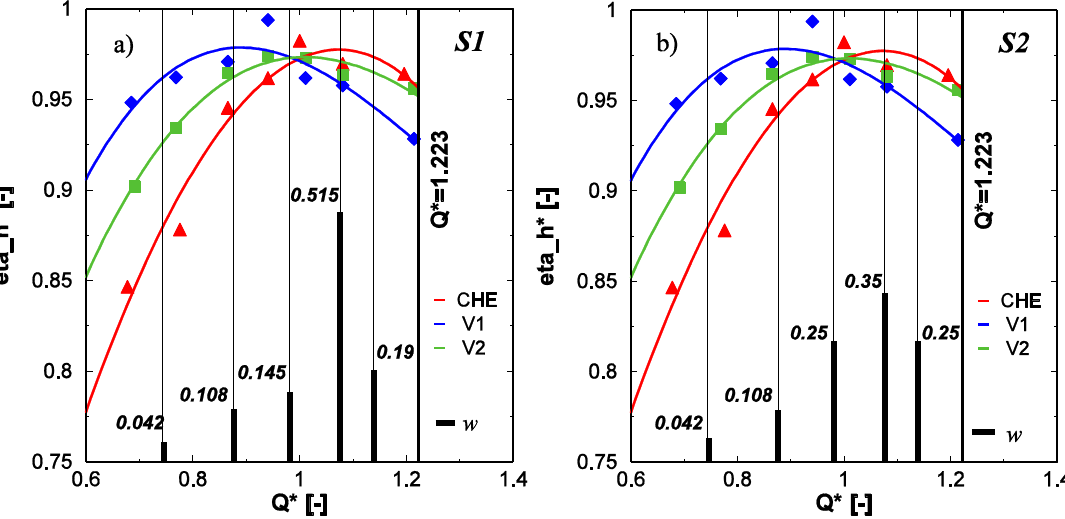
∗ Fig. 6. The hydraulic ef fi ciency ( h h ) versus the normalized discharge ( Q *) and the weights associated to two scenarios: (a) scenario No. 1 ( S1 ) and (b) scenario No. 2 ( S2